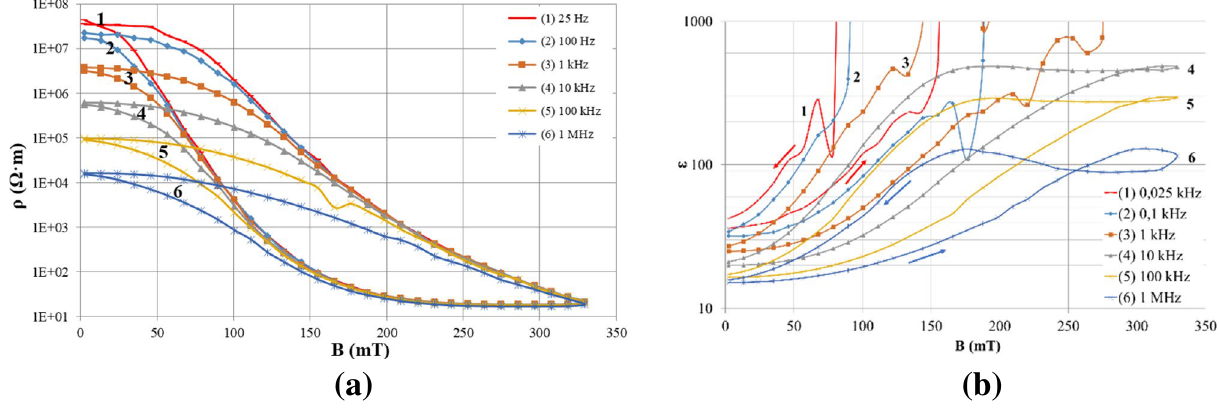
ticles in n -heptane followed by electroplating with metal nickel (the concentration of nickel in the pure powder is 2.46 wt%). The way the specified parameters change with the field is shown with arrows